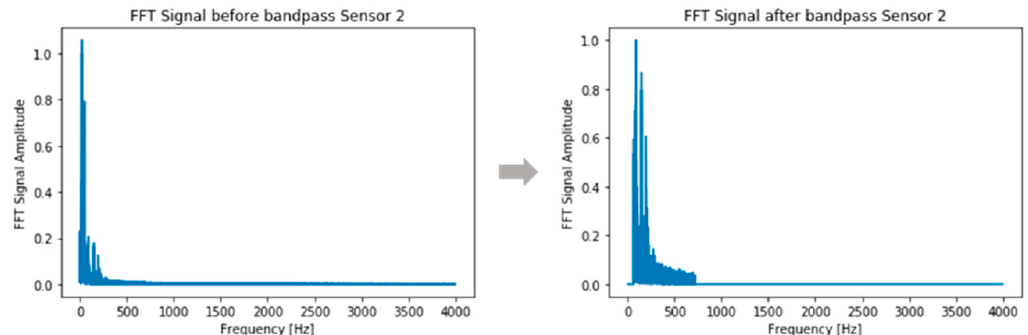
Figure 12. Bandpass filter operation to retain data within frequency ranges of interest.